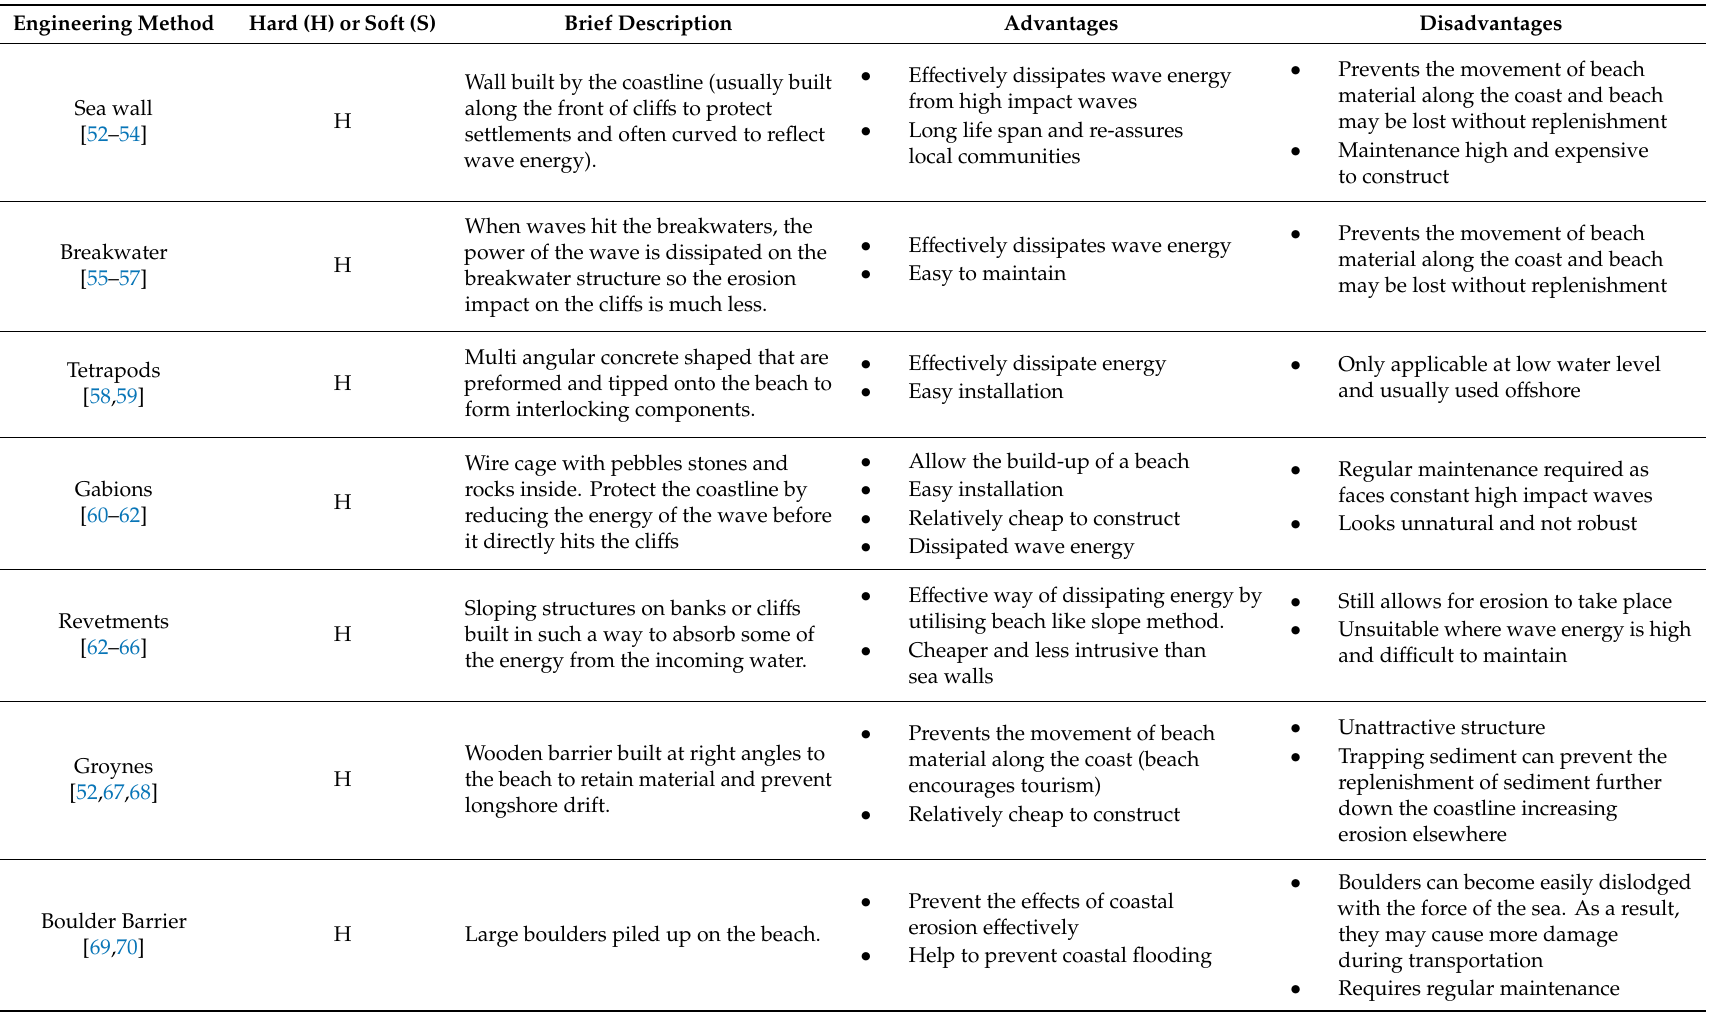
Table 1. A review of existing coastal protection measures with advantages and disadvantages identified for each